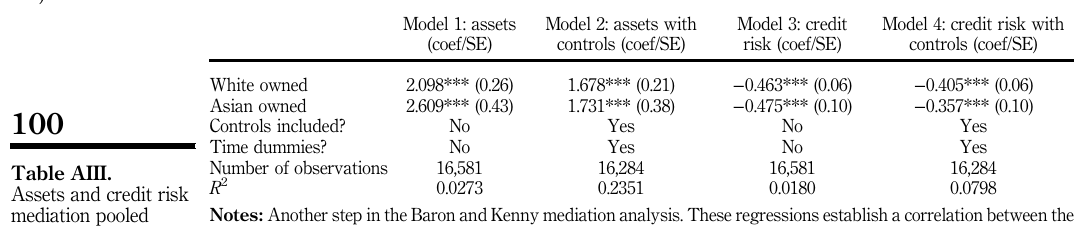
Model 1: Survival – logit (coef/SE)